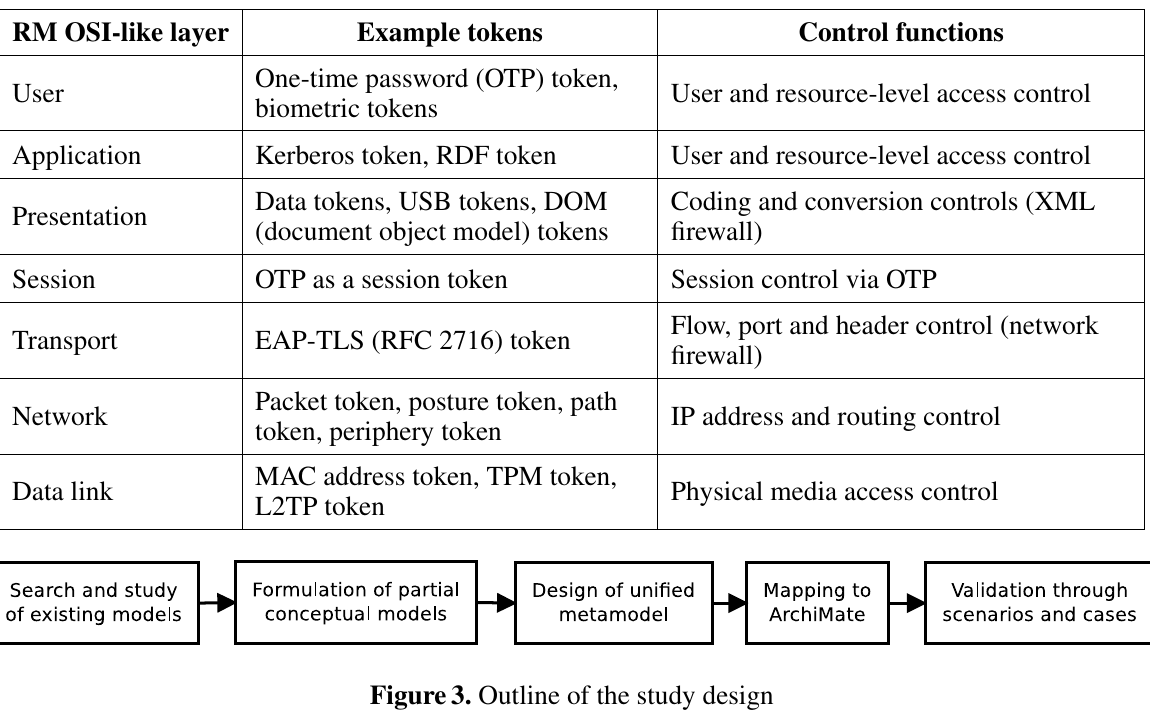
Table 3. Examples of TBAC tokens according to [44]